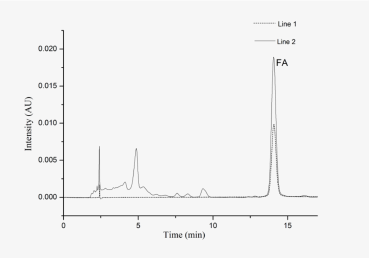
Figure 4. High-performance liquid chromatography (HPLC) chromatogram of 5 µ g / mL FA standard solution (line 1) and the extract of sample 1 (line